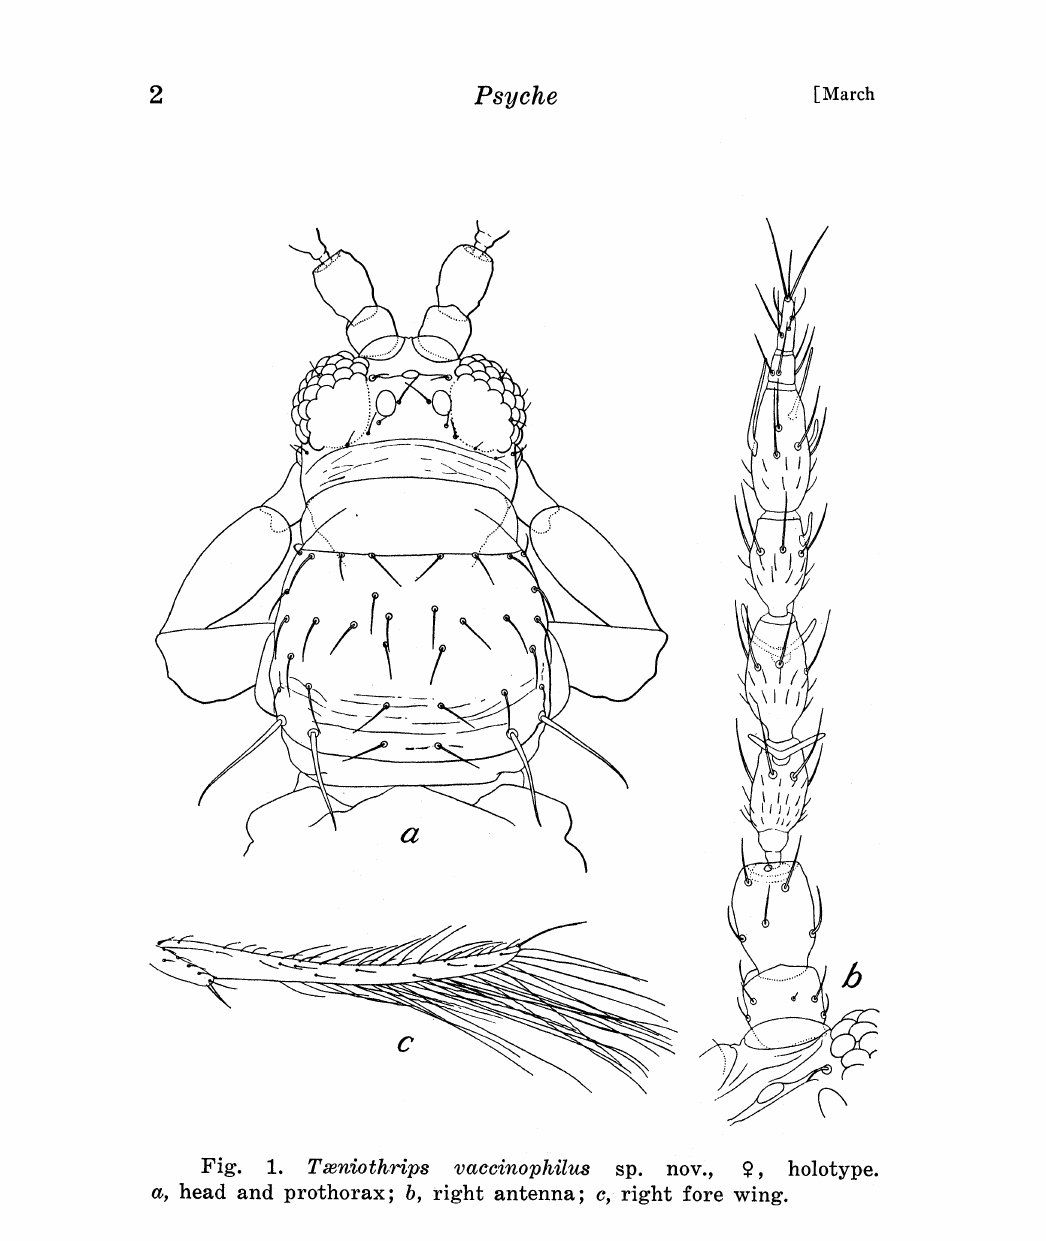
Fig. 1. Tteniothrips vaccinophilus sp. nov., 9, holotype. head and prothorax; b, right antenna; c, right fore